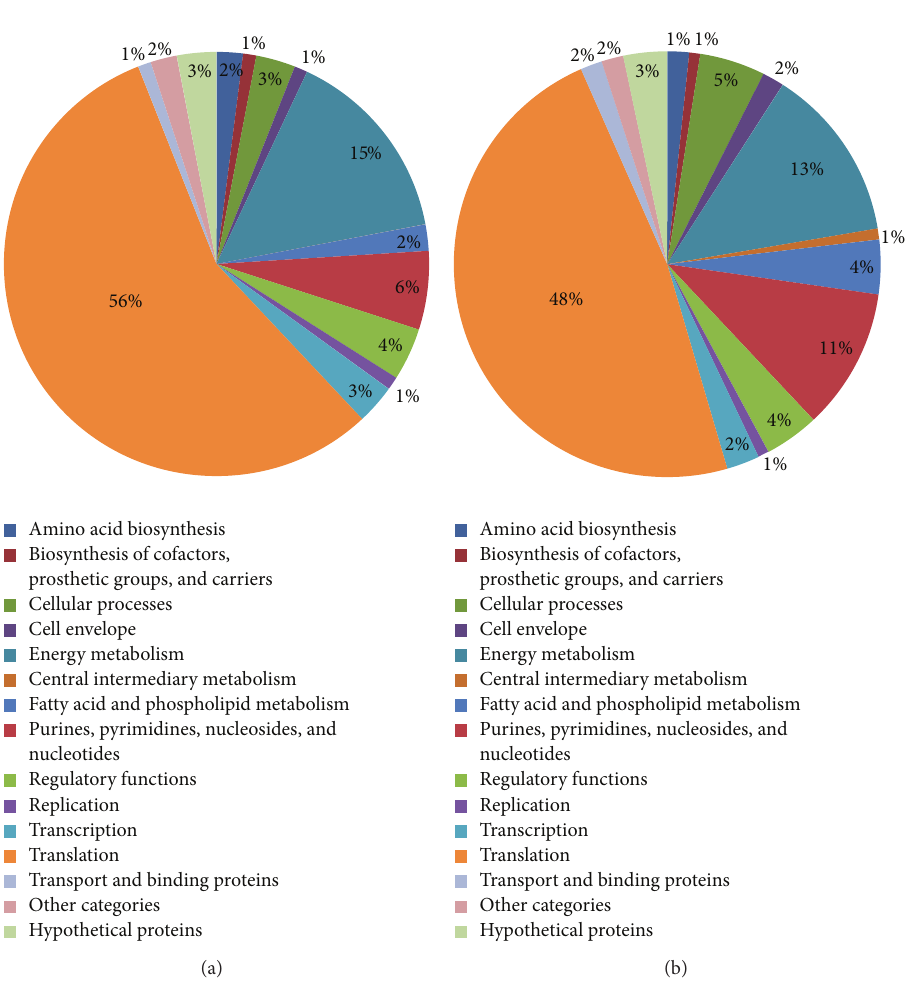
Figure 1: Comparison of the growth phase-dependent proteomes of L. lactis strain M4. Panel (a), the bar charts show the comparison of the number of proteins found in the biological replicates. Panel (b), the Venn diagrams show the comparison of the proteomes during the mid-exponential and early stationary growth phases.